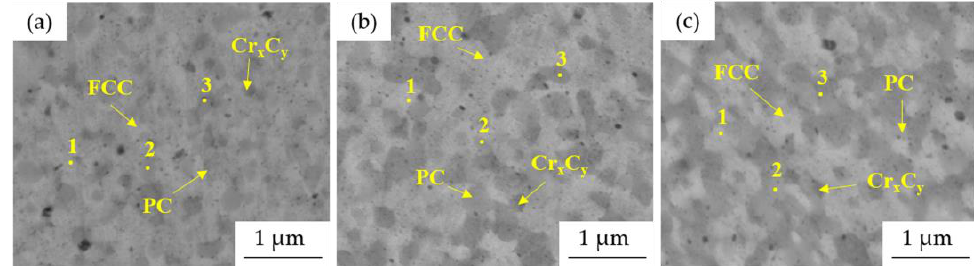
Figure 7. SEM micrographs and points of EDS analysis of MA + SPS compact alloys: ( a ) Mn15Al5, Table 4. SEM + EDS analysis of the chemical composition of points marked in Figure 7. Concentration Alloy Point